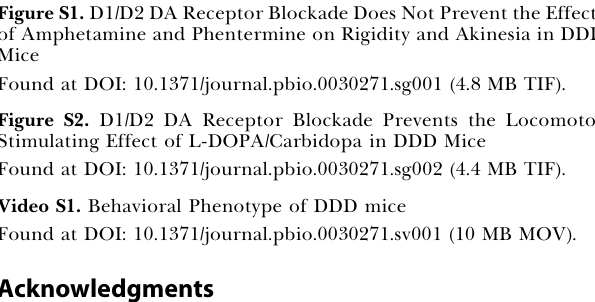
Figure S1. D1/D2 DA Receptor Blockade Does Not Prevent the Effects of Amphetamine and Phentermine on Rigidity and Akinesia in DDD Mice Found at DOI: 10.1371/journal.pbio.0030271.sg001 (4.8 MB TIF). Figure S2. D1/D2 DA Receptor Blockade Prevents the Locomotor Stimulating Effect of L-DOPA/Carbidopa in DDD Mice Found at DOI: 10.1371/journal.pbio.0030271.sg002 (4.4 MB